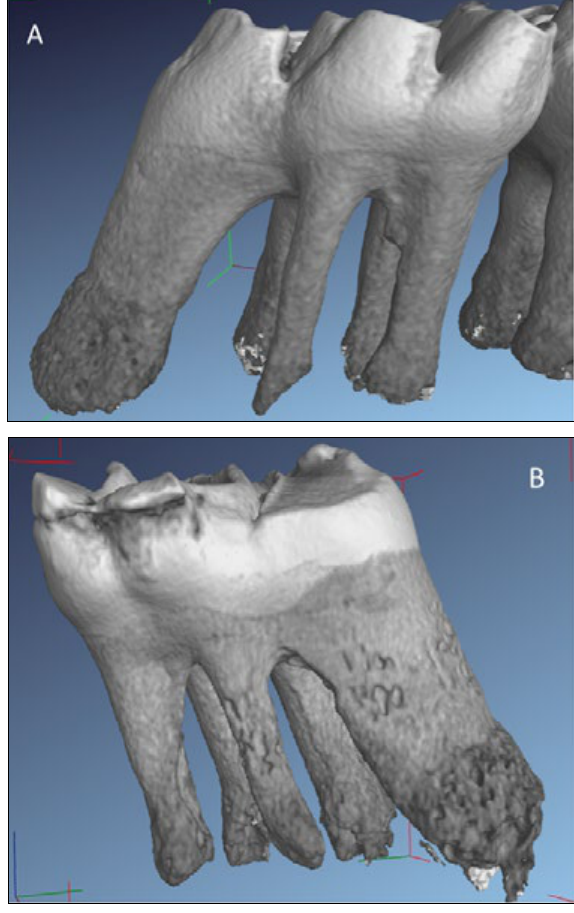
Figure 3. (A) Three-dimensional image of the right first molar. Note minimal root resorption on root surface. (B) Three-dimensional image of the left first molar. Note uneven root surface indicating root